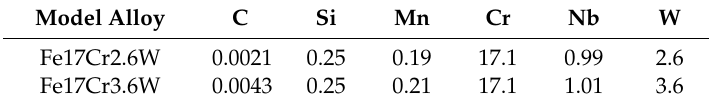
Figure 5. Results of thermodynamic equilibrium calculations of Laves phase amount as a function of tungsten content at 650 ◦ C (ThermoCalc ® , database TCFE8). Table 1. Chemical composition in wt. % of the manufactured model alloys Fe17Cr2.6W and